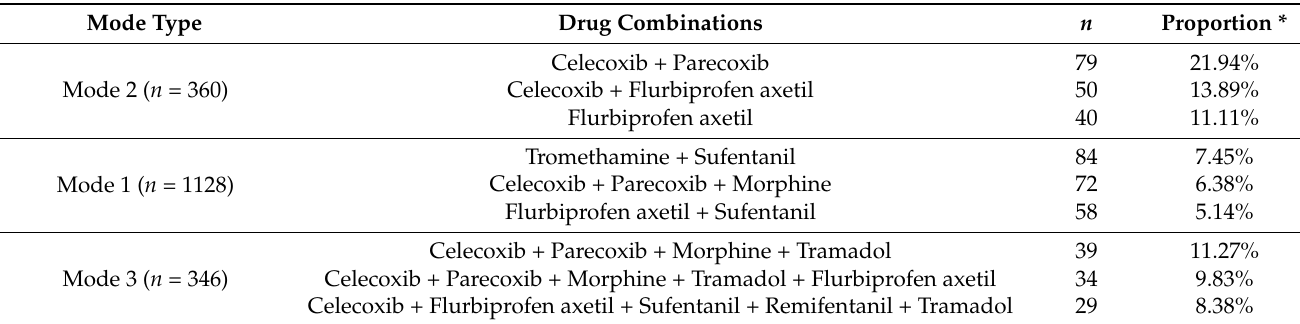
Table 5. Top 3 drug combinations in main modes of analgesics utilization.